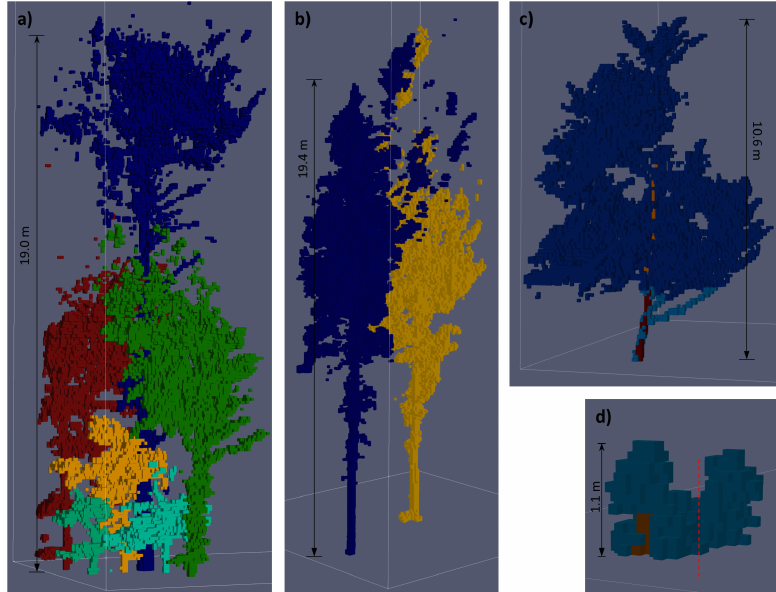
Figure 6. Examples of isolated trees. ( a ) shows a group of well isolated trees in a vertically structured composition; ( b ) gives an example of major trees with isolated fragments at the crown top and at the image border; ( c ) shows a splitting error, where the lower stem part and the crown were separated into two clusters (tones of blue) due to erroneously split stem priors (tones of brown); ( d ) is an example for a merge error of a very small tree cluster. The cluster is clearly separable into two trees (red line), but only one stem prior is existing (brown